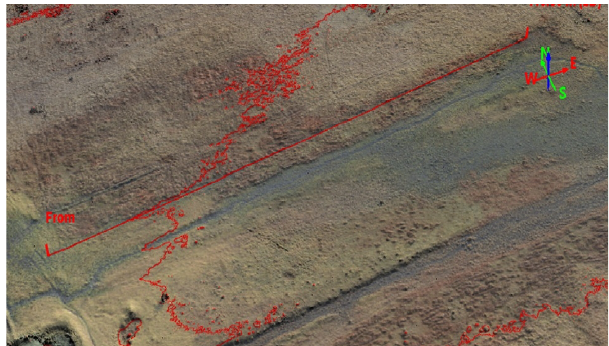
Figure 3. DTM with orthophoto overlay used to determine the density of drains in the wetland